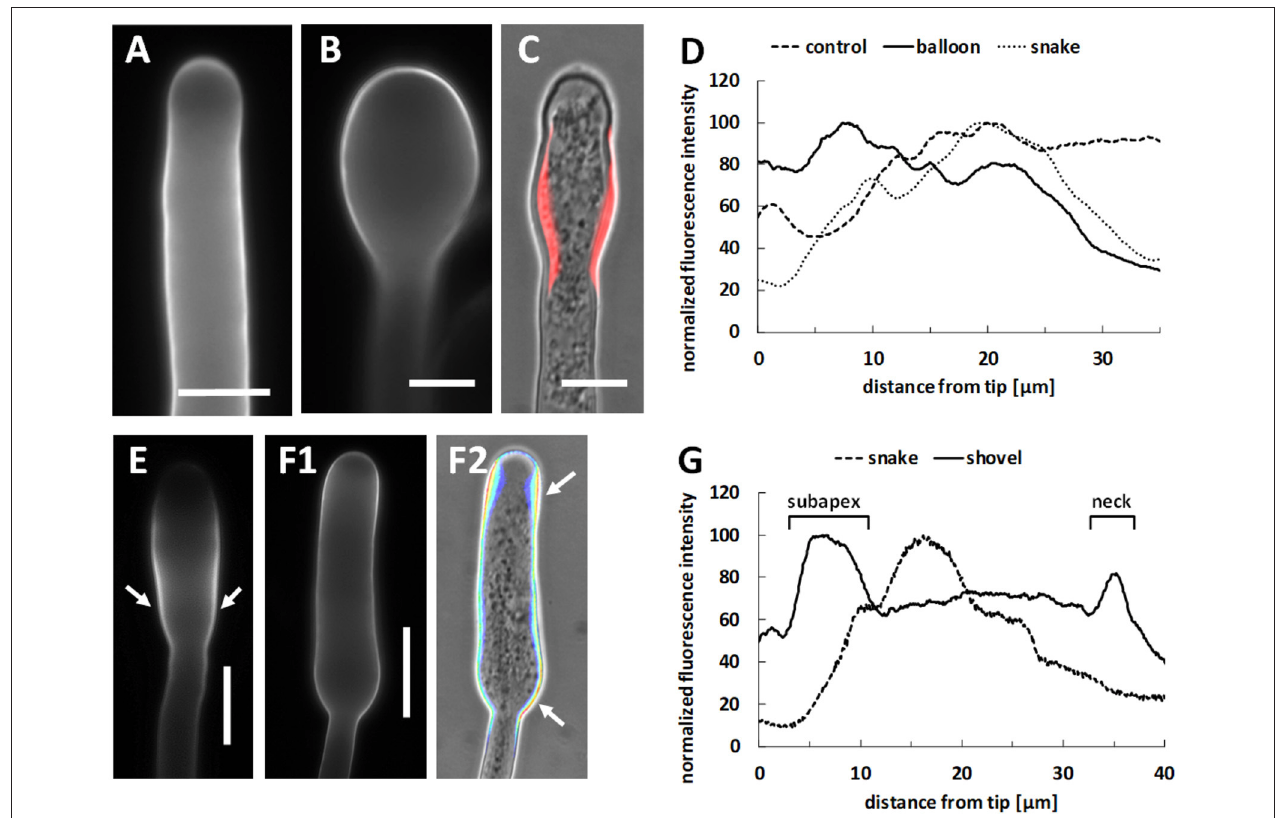
FIGURE 10 | Distribution of cellulose in Spm-treated pollen tubes. (A) Pattern of cellulose in control pollen tubes. (B) Cellulose distribution at the onset of Spm treatment (balloon stage). (C) Distribution of cellulose at the snake stage; in this case, fluorescence of cellulose was thresholded to evince the sites of major accumulation and superimposed to the DIC view of the same pollen tube in order to emphasize the sites of cellulose accumulation. (D) Graph of relative fluorescence intensity at the balloon/snake transition (compared to control) starting from the tip. Data are representative of three independent experiments (E) Image of a pollen tube at the snake stage showing accumulation of cellulose in the neck and in enlarged regions (arrows). (E,F1,F2) Representative image of a pollen tube at the shovel stage. Cellulose accumulates all along the pollen tube but more prominently in the subapex and in the neck regions (arrows) as shown by pseudocolored fluorescence signal merged with the DIC view. Bars in (A–C) 10 µ m. Bar in (E,F1,F2) 20 µ m. (G) Graph reporting the relative fluorescence intensity in pollen tubes at the shovel stage starting from the tip. The so-called “enlargement zone” represents the point where the diameter of that specific pollen tube increases. Data are representative